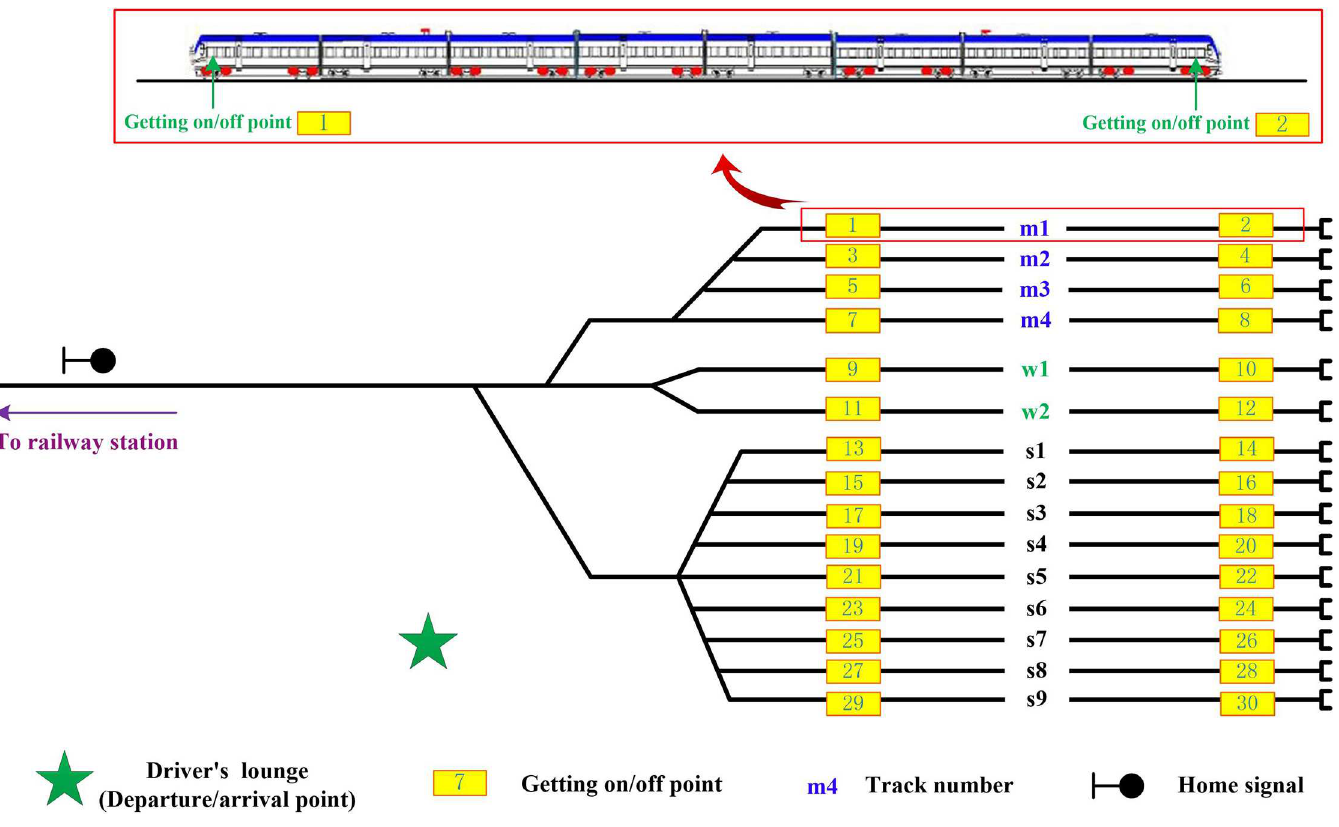
Fig 2. A typical depot track layout with getting on/off